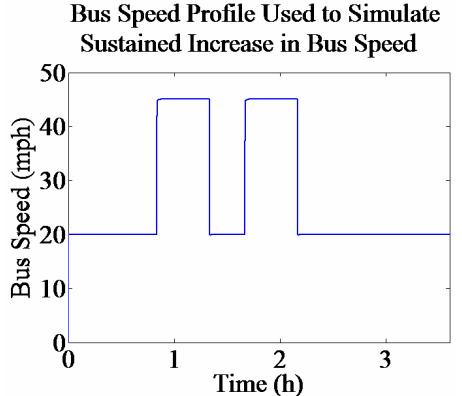
Figure 11. Idealized bus speed profile used to simulate bus operation with a roof-installed PV array. The profile contains two, 30-min periods where bus speed is increased from 20 mph to 45 mph (the maximum bus speed) and subsequently decreased to 20